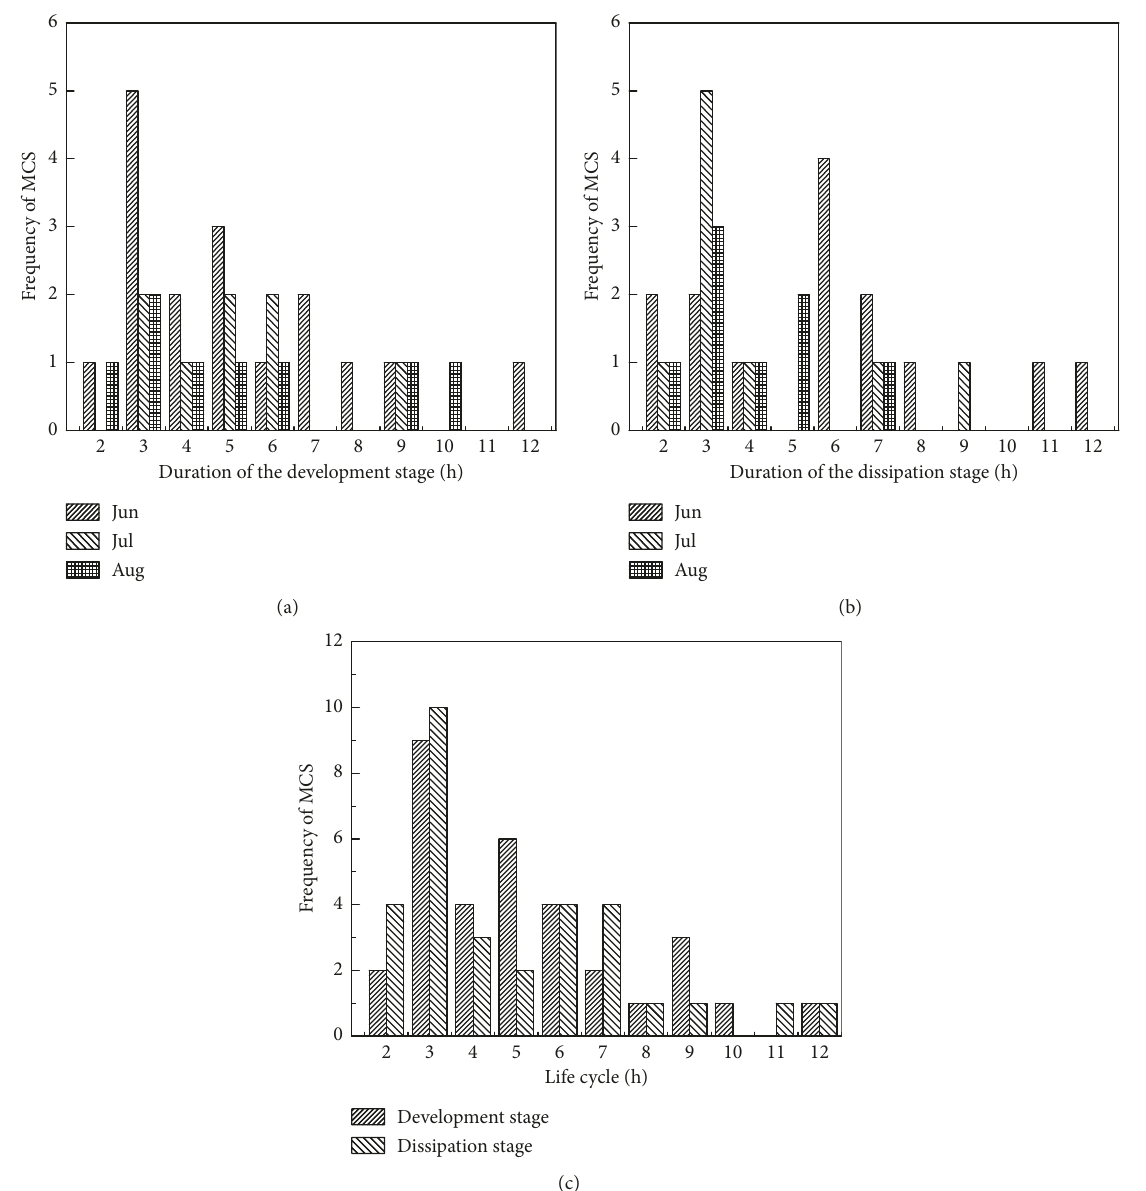
Figure 7: Frequency distribution of the MCSs in every month and the total durations of the (a) development and (b) dissipation stages. (c) Total frequency distribution of both